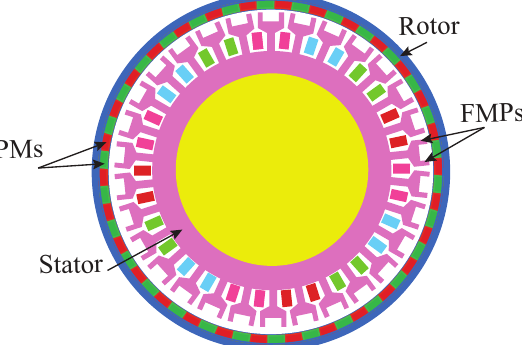
Figure 6. Permanent-Magnet Vernier Machine.